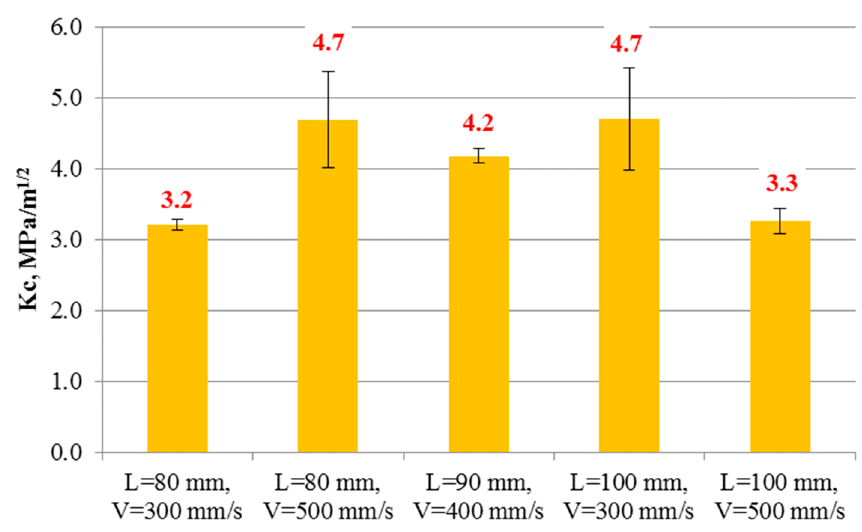
Figure 11. The fracture toughness of AT13 coatings.